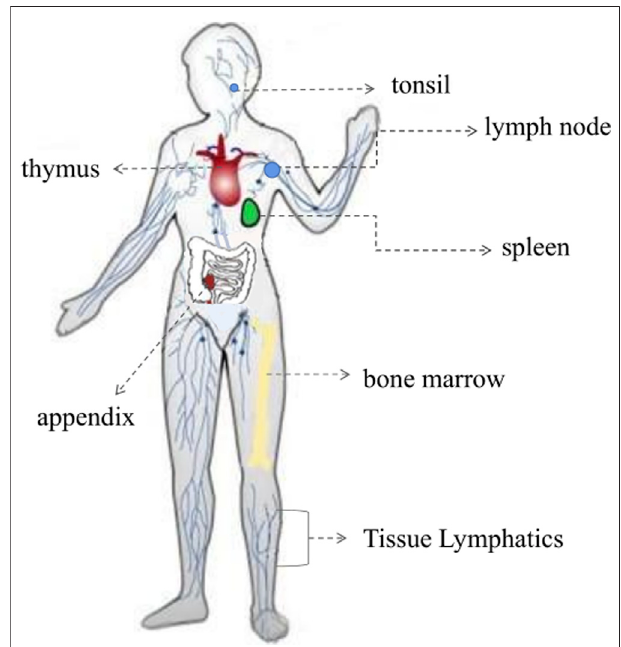
FIGURE 6 | The immune system of immune